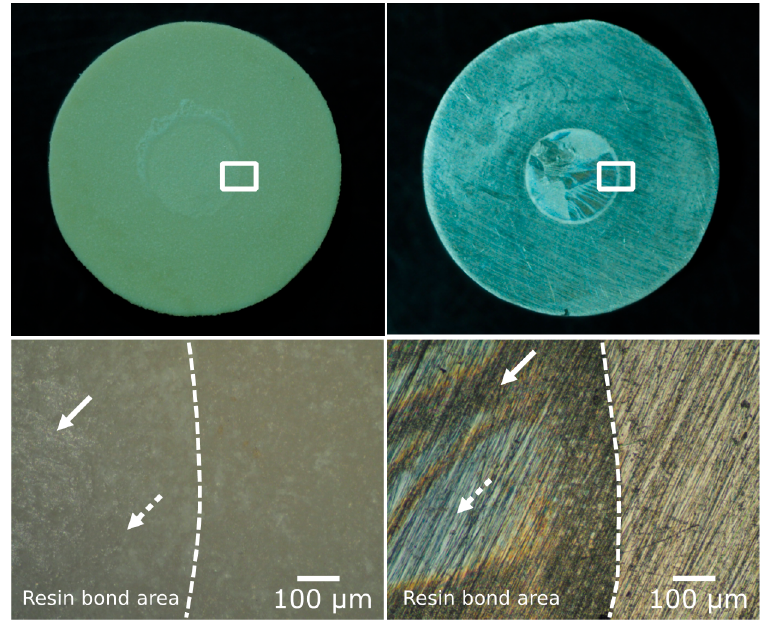
Figure 4 . Failure cross-section (stereoscopic observations, 100×). Left : PEEK with Rocatec and ceramic primer (RCC) bonded to Palapress Vario, Right : Co-Cr alloy with metal primer bonded to Palapress Vario. The dashed line shows a boundary between the resin bond area and non-bond area. The arrow indicates resin remaining on the surface. The dotted arrow indicates no resin remaining on the surface.